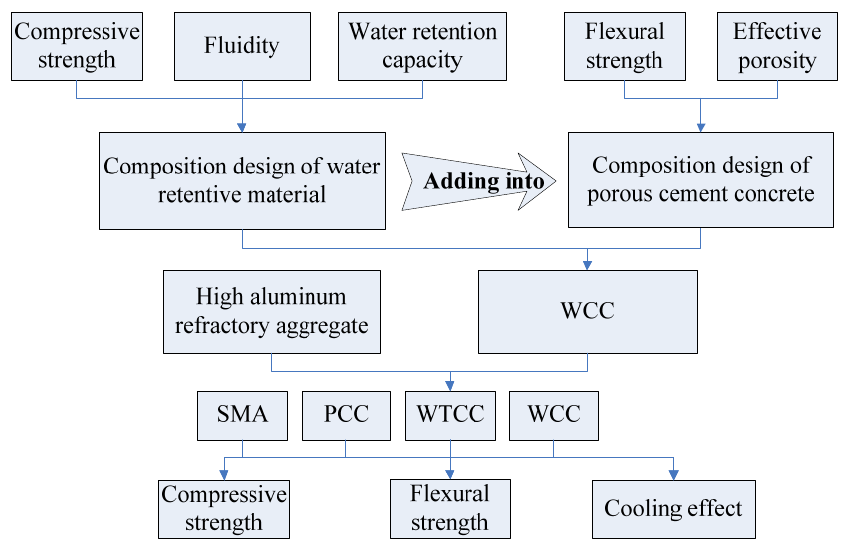
Figure 1. Schematic development of WTCC and test program.